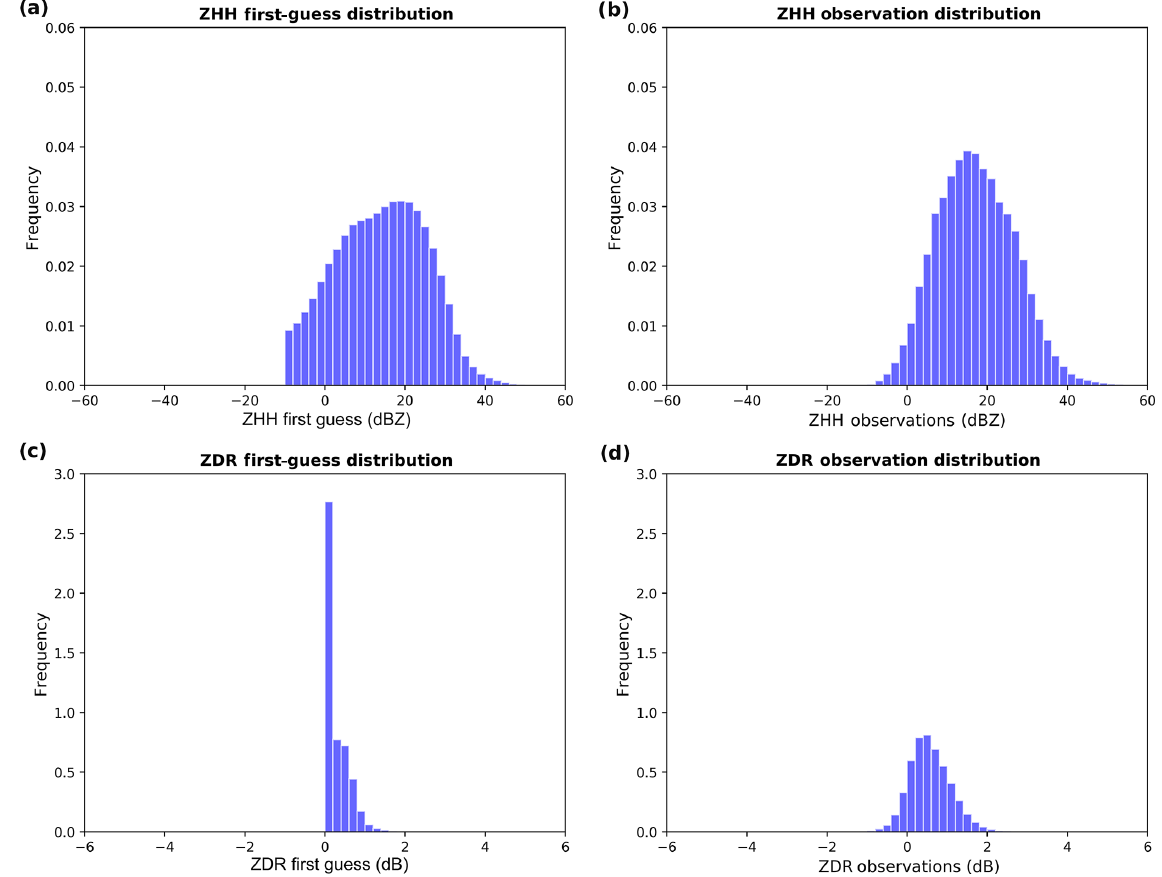
Figure 7. First-guess (a, c) and observation distributions (b, d) for Z HH (a, b) and Z DR (c, d) .